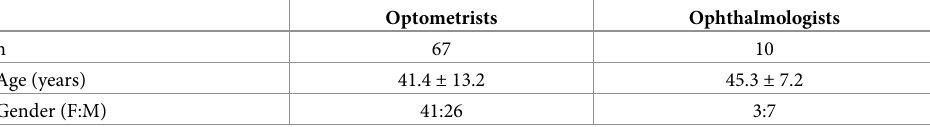
Table 3. Demographic characteristics of the eyecare professionals participating in the